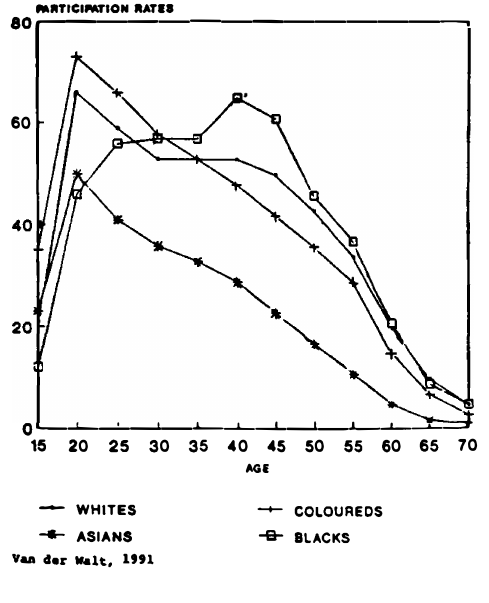
Figure 2 Participation rates by age group - women in 1985 it, to be supported by their husbands and to raise their c h i l dr e n ( s ee F i g u r e 2 ) . The level of occupational segregation by gender is